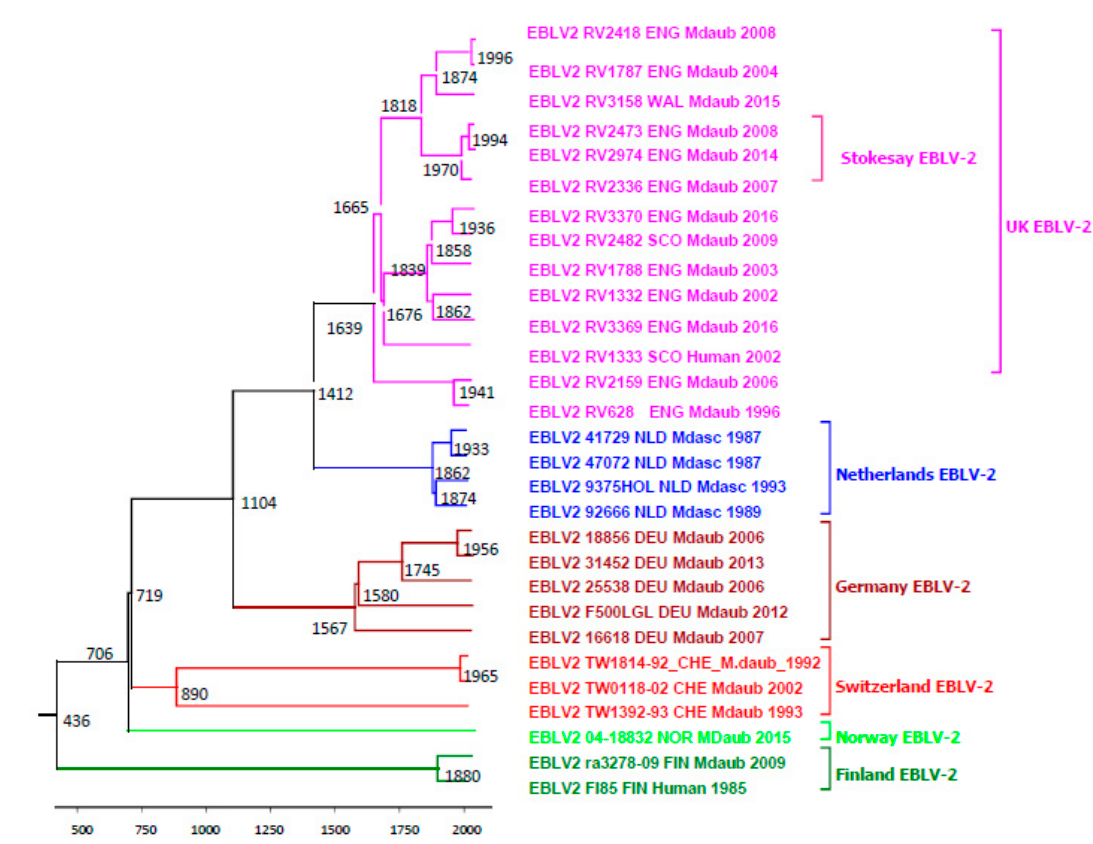
Figure 3. Bayesian maximum clade credibility (MCC) tree of 29 EBLV-2 concatenated gene sequences (10818 nucleotide sites comprising the nucleoprotein, matrix, phosphoprotein, glycoprotein, and polymerase genes) with branch lengths scaled in time by enforcing a relaxed molecular clock. The EBLV-2 strains are coloured to indicate the location of sampling. Mean substitution rate of the dataset was 1.7 × 10 − 5 .